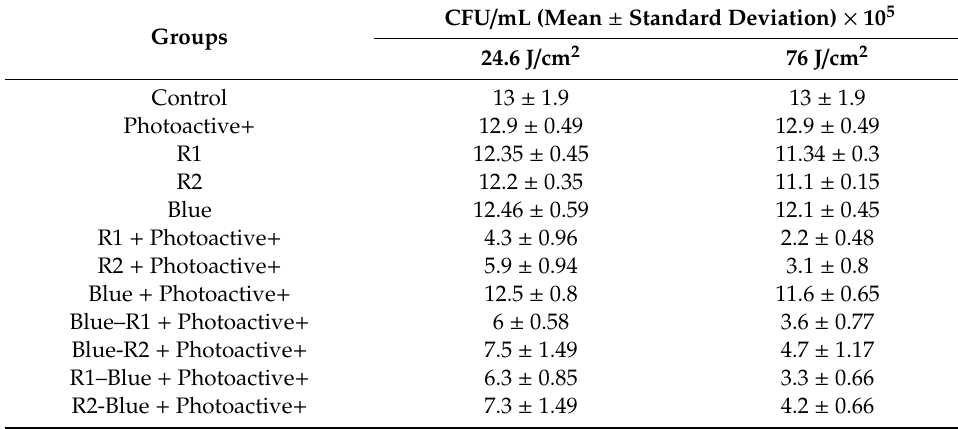
Table 2. Mean ± standard deviation of experimental